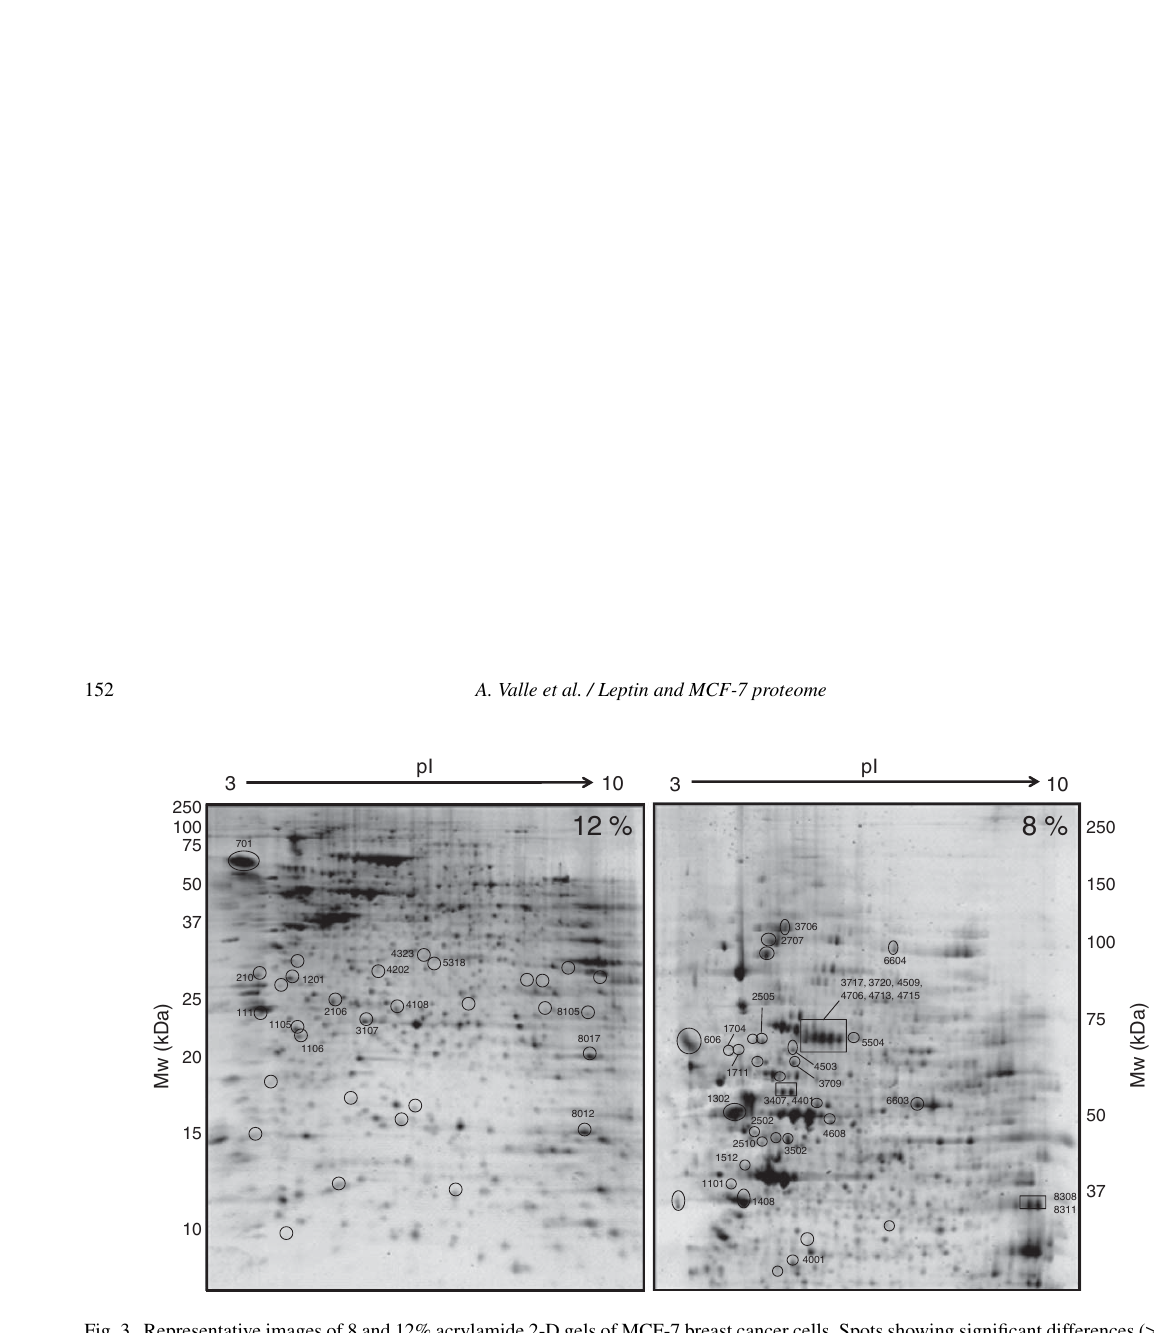
Fig. 3. Representative images of 8 and 12% acrylamide 2-D gels of MCF-7 breast cancer cells. Spots showing significant differences (>1.5 fold change and p <0.05) between leptin-treated and control cells are encircled. Protein spots identified by MALDI-TOF MS are marked by their spot